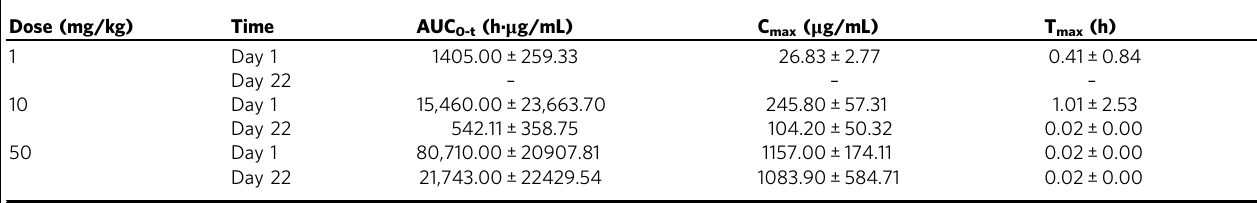
Table 2 Main toxicokinetic (TK) parameters of IBI319 after multiple intravenous injections at 1, 10 or 50 mg/kg (mean ± SD, n = 10).